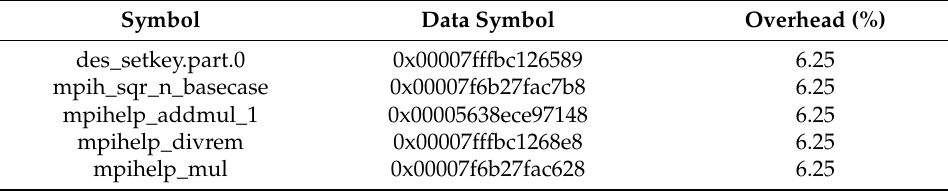
Table 6. Legit RSA decryption program detection results of